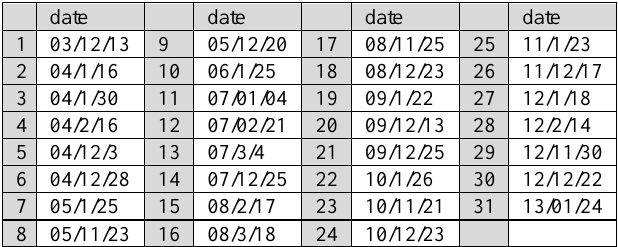
Table 2. Data Collection from MODIS sensor